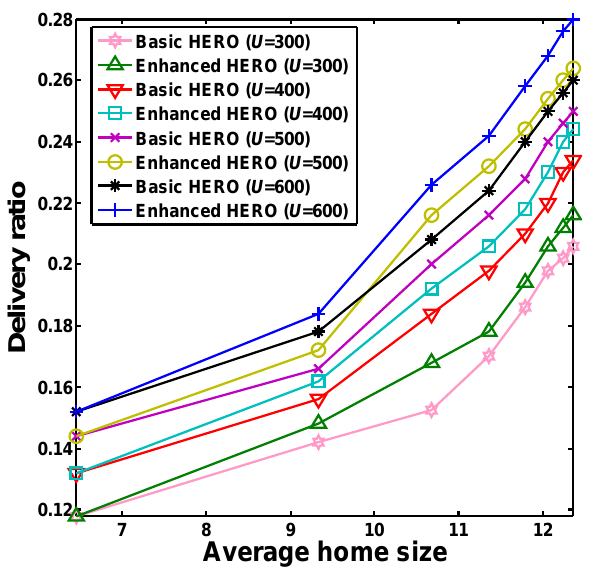
Figure 6. The impact of home size on the delivery ratio of HERO, which shows that delivery ratios are improved with the increase of average home size in all scenarios.